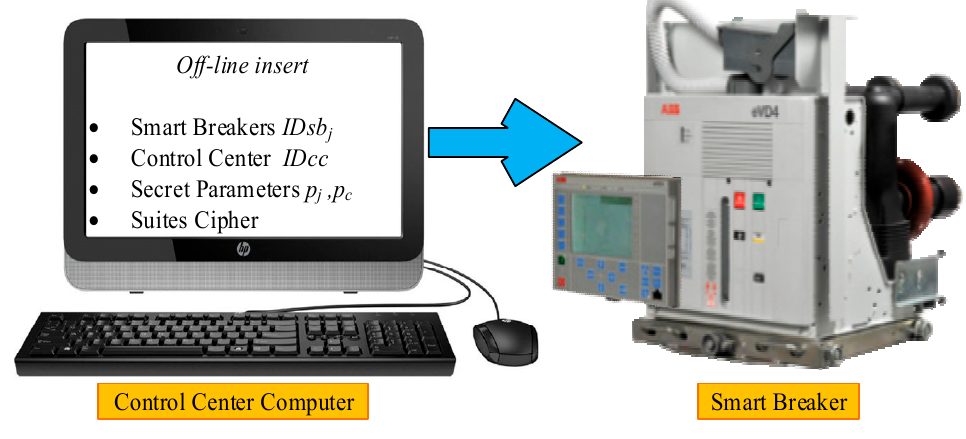
Figure 4. Initialization phase.